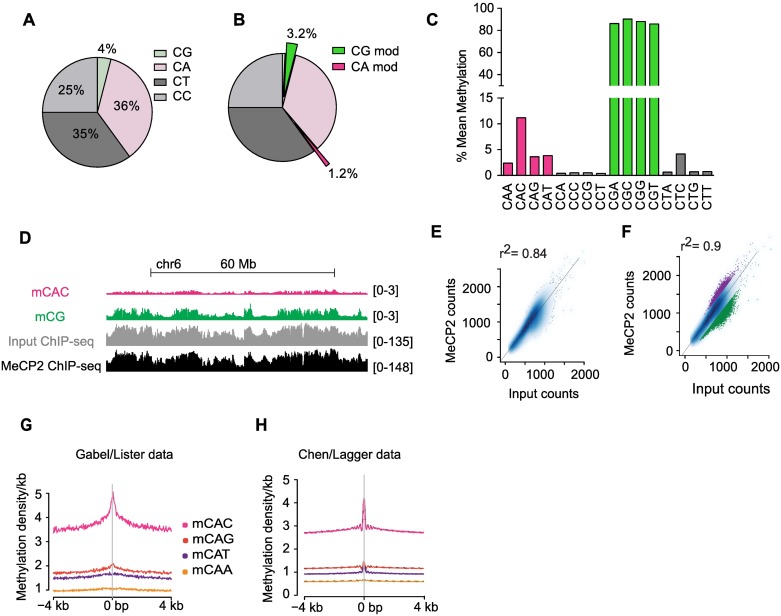
DNA methylation and MeCP2 binding in the mouse brain.(A) Pie chart showing CX frequencies in the mouse genome (dataset WGBS of sorted neurons from this study). (B) Pie chart showing modified (mC and hmC) CX frequencies in brain neuronal nuclei as determined by WGBS (dataset WGBS of sorted neurons from this study). (C) Mean methylation levels (%) of CXX in brain neuronal nuclei based on WGBS of sorted neurons (dataset from this study). (D) IGV browser screenshot of mCAC, mCG, MeCP2 ChIP-seq and corresponding Input DNA based on sequence reads. Data represent a 100 Mb region of chromosome 6 (datasets from [3,27]). (E) Correlation between sequence coverage of MeCP2 ChIP-seq and corresponding Input DNA in 10 kb windows. Fitting a linear model (MeCP2 ~ Input) yields a coefficient of determination of 0.84 (dataset from [27]). (F) As for (E) but highlighting relative depletion (4.1% of windows; green) and relative enrichment (1.7% of windows; purple). When these outliers are excluded, 90% of the variability of the MeCP2 signal in the remaining binned windows is explained by sequence bias (Input coverage) (dataset from [27]). (G-H) Enrichment of mCAC at summits of MeCP2 binding using ChIP-seq and WGBS datasets from matching brain regions ([3,26] (G) and [27] and this study (H)).